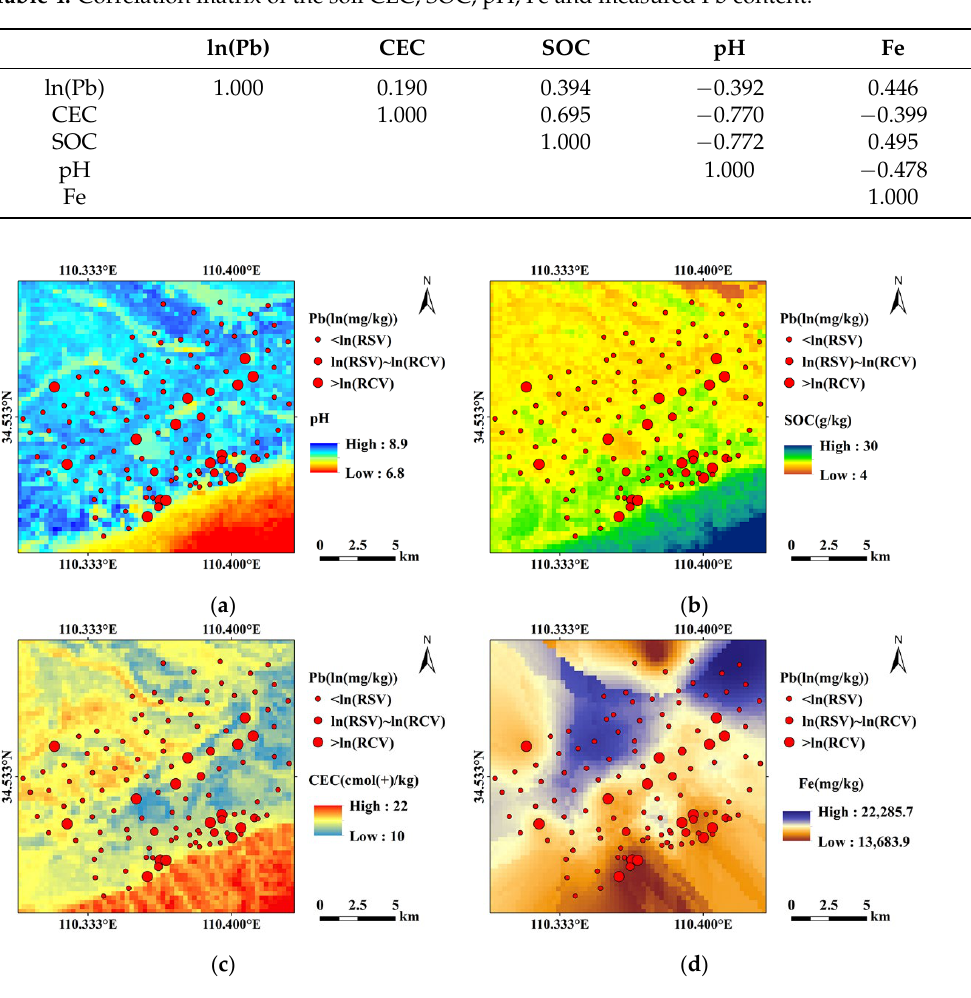
Figure 11. Spatial relationships among soil pH, SOC, CEC, Fe and measured Pb content, ( a ) soil pH and measured Pb content; ( b ) soil SOC and measured Pb content; ( c ) soil CEC and measured Pb content ; ( d ) soil Fe and measured Pb content .